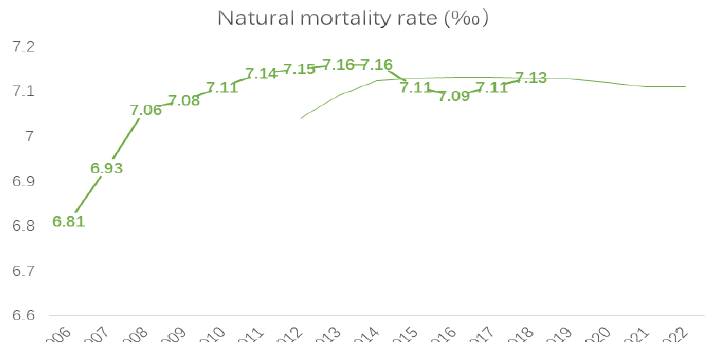
Figure 5. Natural mortality rate.